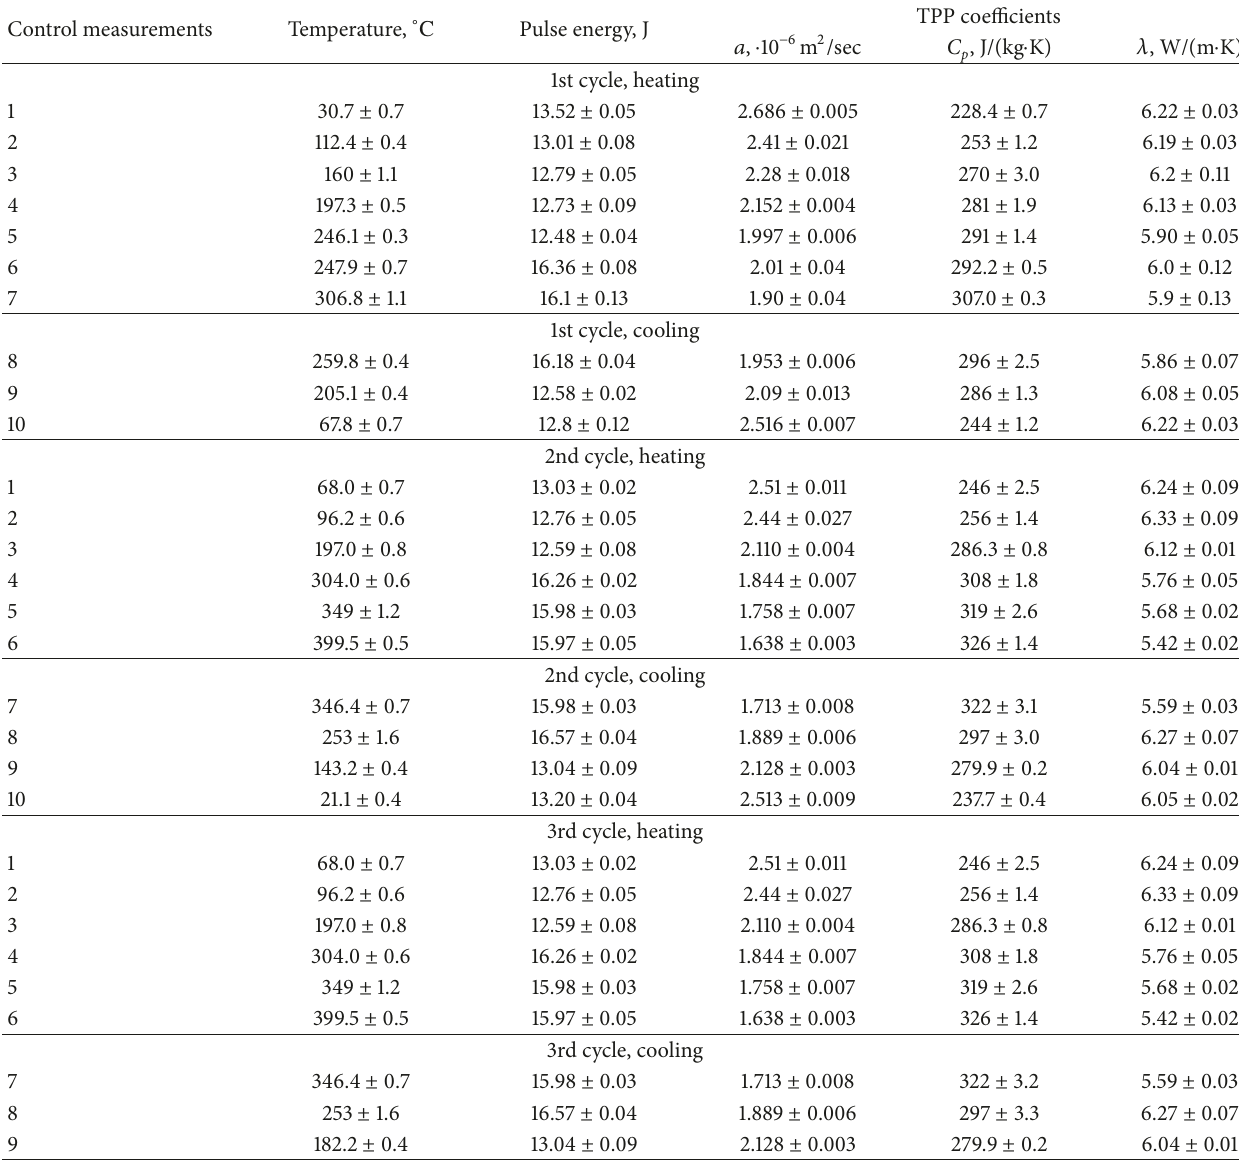
Table 8: Results of temperature changes of sample number 1 TPP coefficients